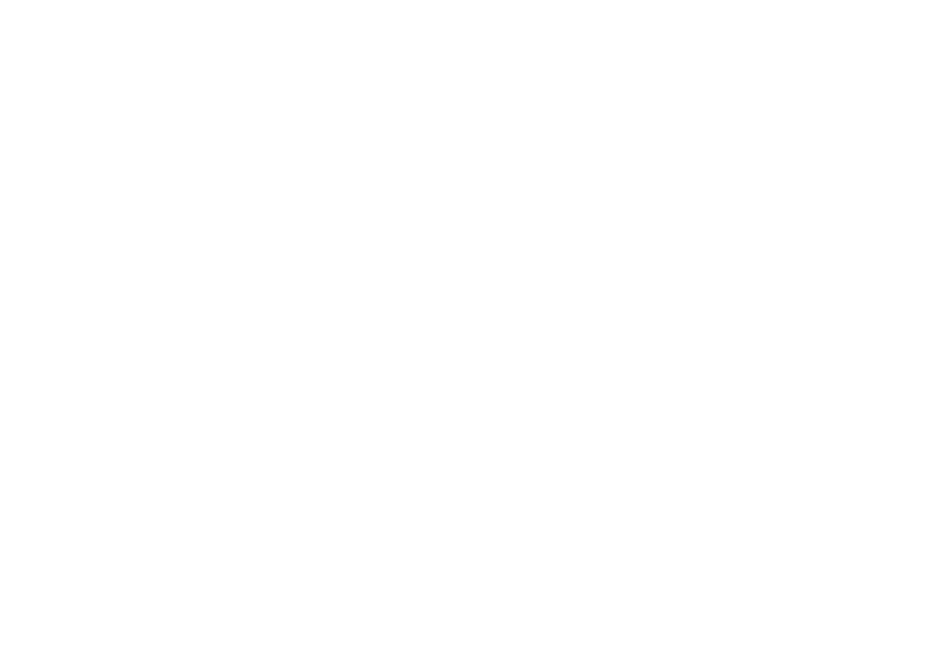
FIGUREA1 | (A) Data distribution of the 268 ESTs identified as being differentially regulated ( q < 5%) by DA in hypothalamus. (B) Annotation distribution of the 110 annotated ESTs. In the telencephalon (not shown), a total of four sequences were found of which three had blast hits, and only two were